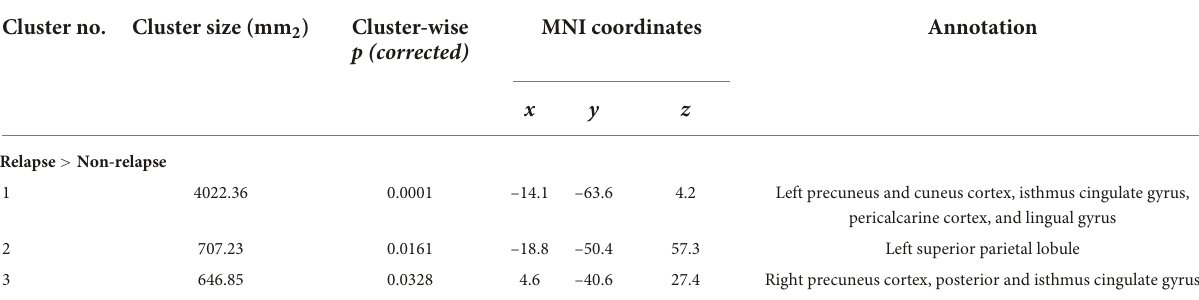
TABLE 2 Clusters with significant group differences in local gyrification index. Cluster